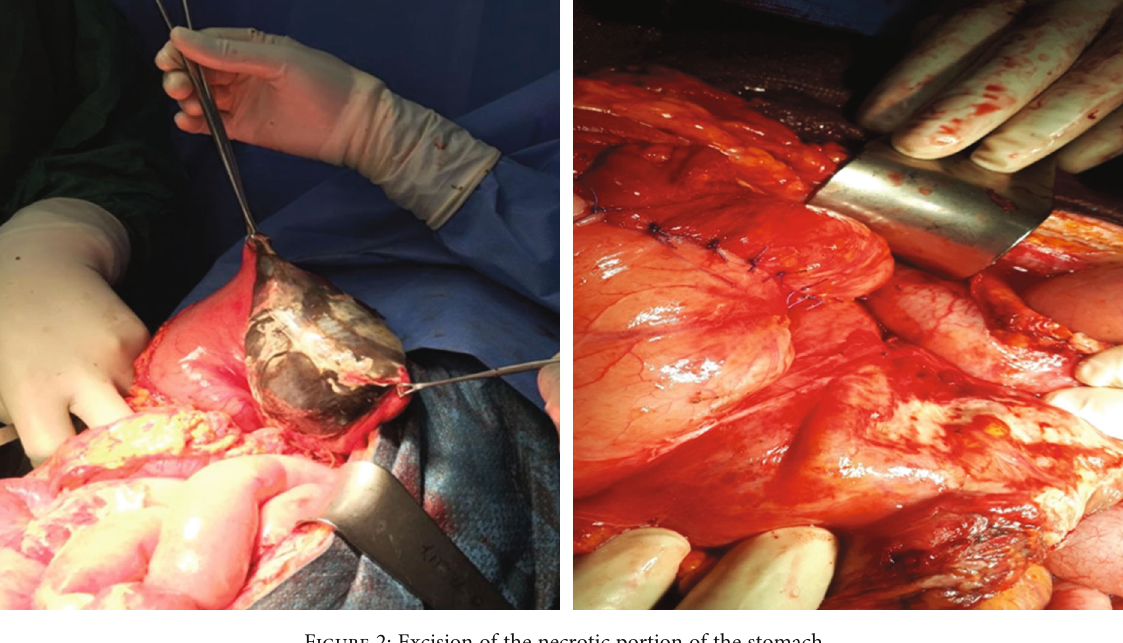
Figure 2: Excision of the necrotic portion of the stomach.